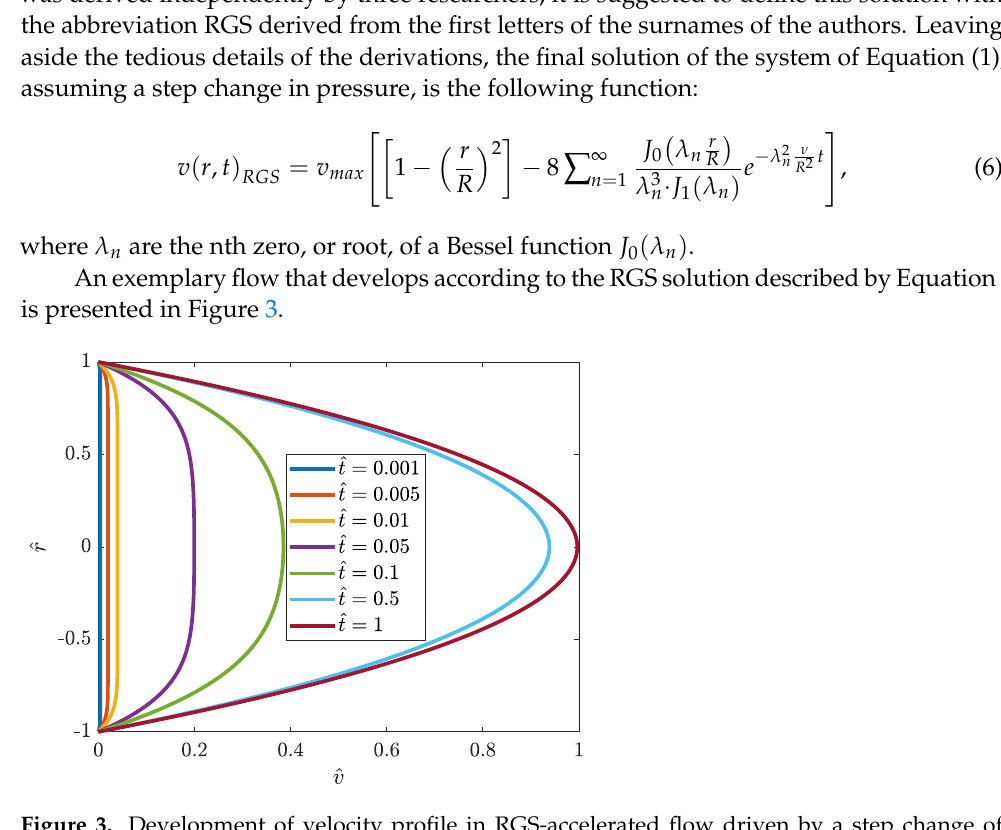
Figure 4. Definition of pipe slope angle (adapted from [49]). Knowing the solution for velocity distribution at the pipe cross–section (Equation (6)) enables us to calculate the following important parameters describing unsteady acceler- ated pipe flow: (a) average flow velocity: 𝑣𝑣 𝑚𝑚 = 2 𝑅𝑅 2 ∫ 𝑟𝑟𝑣𝑣 ( 𝑟𝑟 , 𝑡𝑡 ) 𝑅𝑅 0 𝑑𝑑𝑟𝑟 (b) wall shear stress: 𝜏𝜏 𝑤𝑤 = −𝜇𝜇 𝜕𝜕𝜕𝜕 ( 𝑟𝑟 , 𝑡𝑡 ) 𝜕𝜕𝑟𝑟 � 𝑟𝑟=𝑅𝑅 (c) friction factor: 𝑓𝑓 = 8𝜏𝜏 𝑤𝑤 𝜌𝜌𝜕𝜕 𝑚𝑚2 The final form for the RGS-type accelerated flow is [49]: